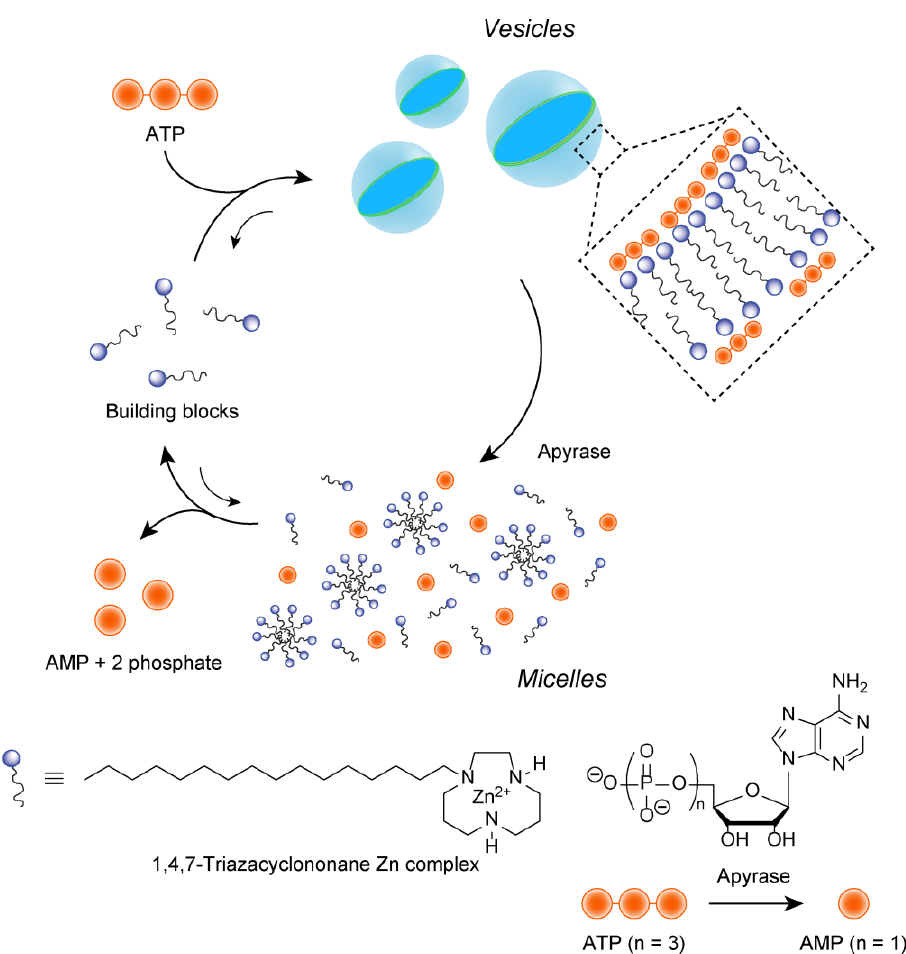
Figure 6. Schematic illustration of a vesicle-micelle transformation cycle coupled with consuming ATP. Apyrase is one of ATP-degrading enzymes.